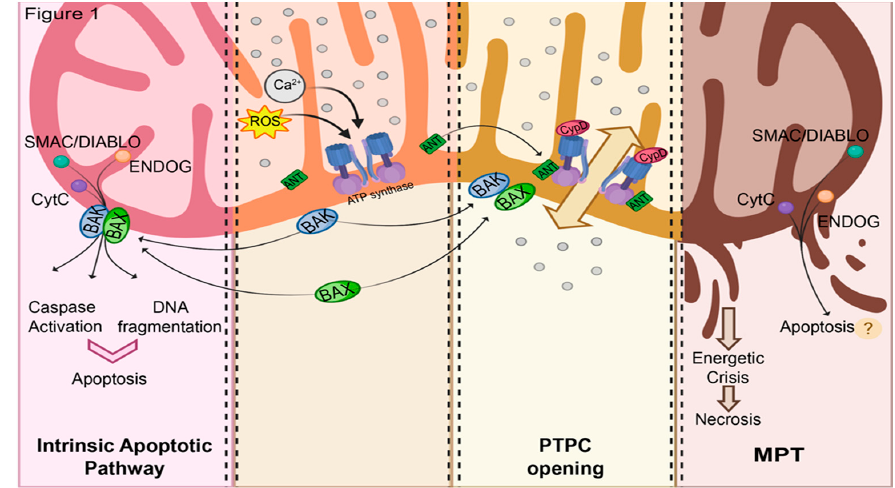
Figure 1. Major molecular paths in mitochondria-related regulated cell death